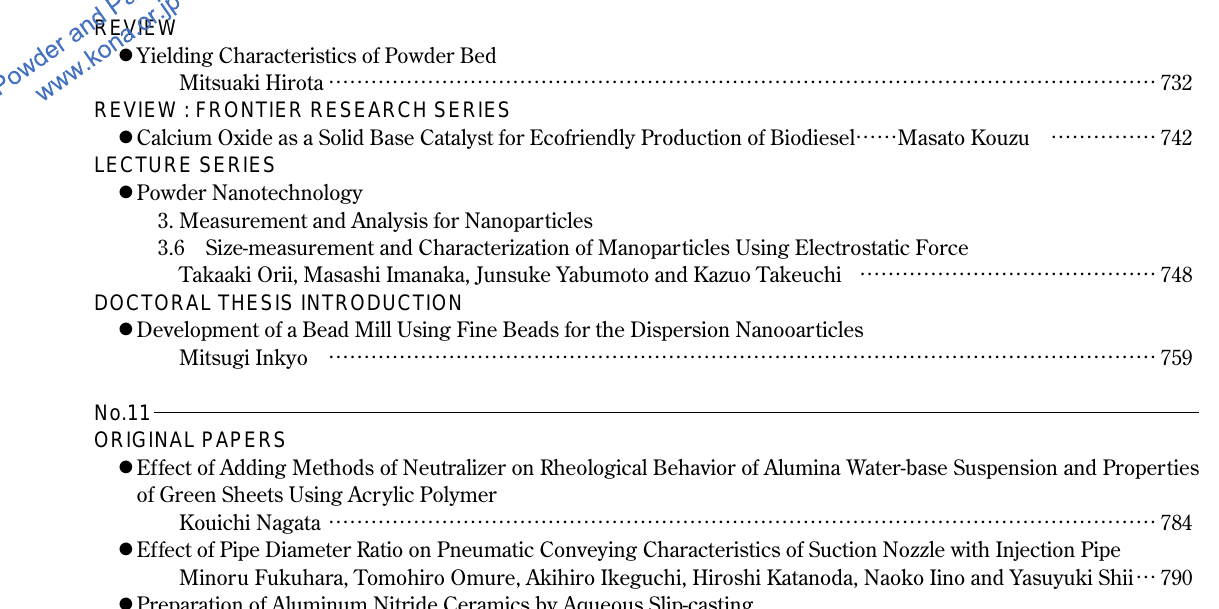
・ Particle Size Distribution Measurement Methods by Use of Classification Effect During Anisokinetic Sampling Hirofumi Tsuji, Hisao Makino and Hideto Yoshida ……………………………………………………………… 806